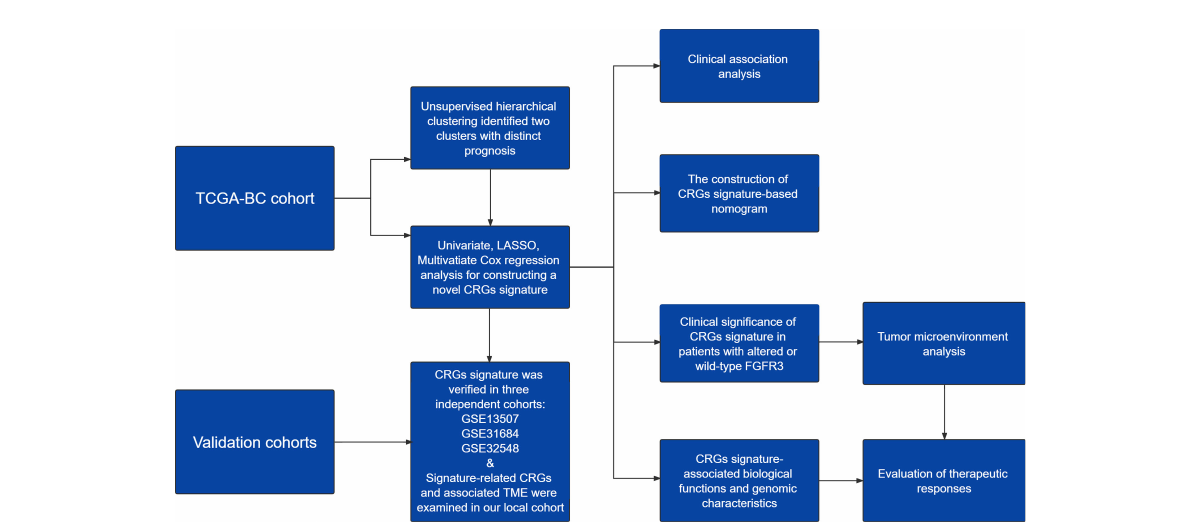
FIGURE 1 A work fl owchart of constructing a novel cell cycle checkpoint gene (CRG) signature, with predictive abilities for prognosis and treatment response in